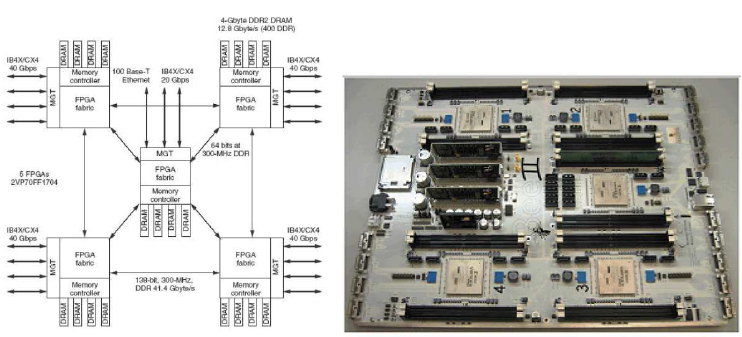
Figure 9. BEE2 system architecture (left) and BEE2 implementation (right).